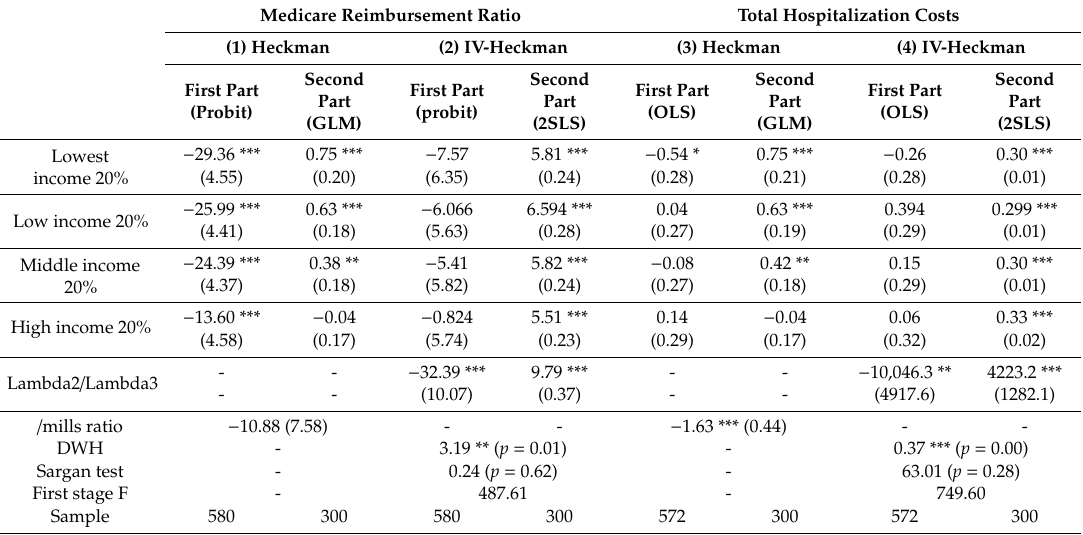
Table 4. Medical insurance compensation level and total hospitalization expenses with restrictions on private health insurance.